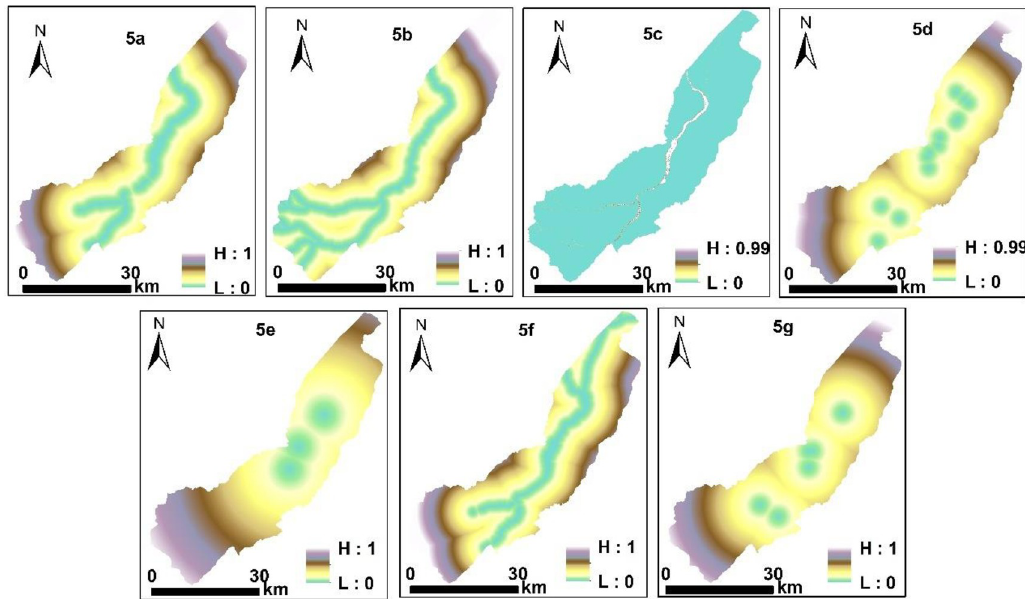
Fig 5. Spatial expression of the influences of the driving factors (Software: ArcMap 10.2.0, http://www.esri.com. Figures were generated with ESRI using author-owned data). 5a Transfer probability of cropland; 5b. Transfer probability of water body; 5c. Transfer probability of unused land; 5d. Transfer probability of administrative centers; 5e. Transfer probability of hospital; 5f. Transfer probability of road; 5g. Transfer probability of school).